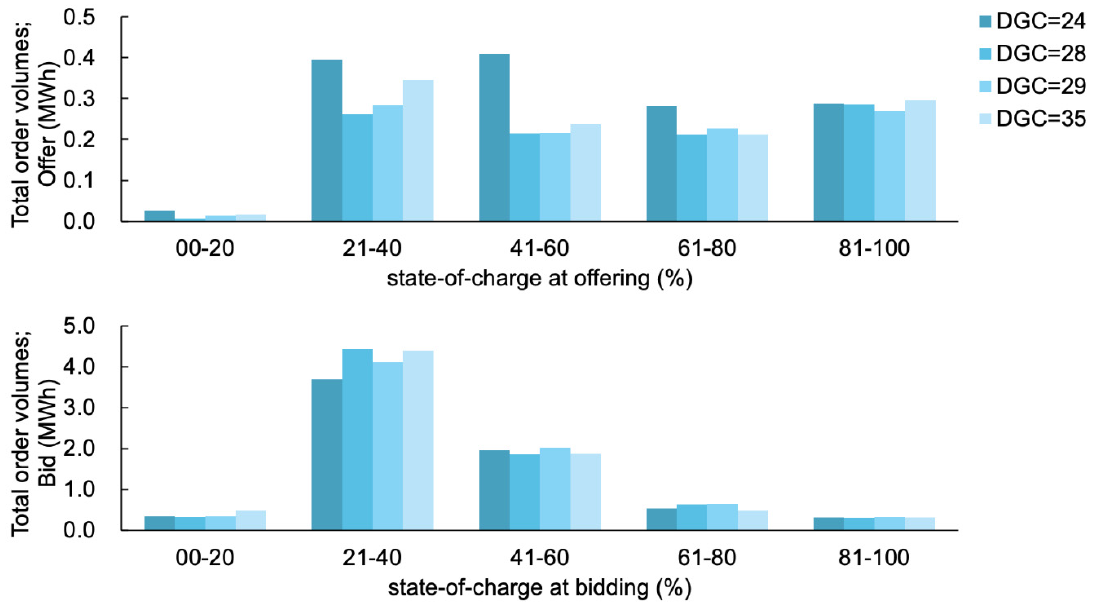
Figure 15. Total order volumes for each (SoC) in the target period.